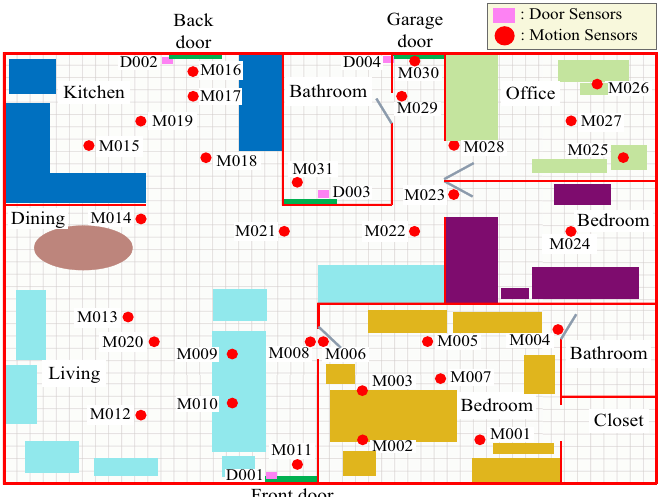
Figure 4. The layout of Aruba and locations of